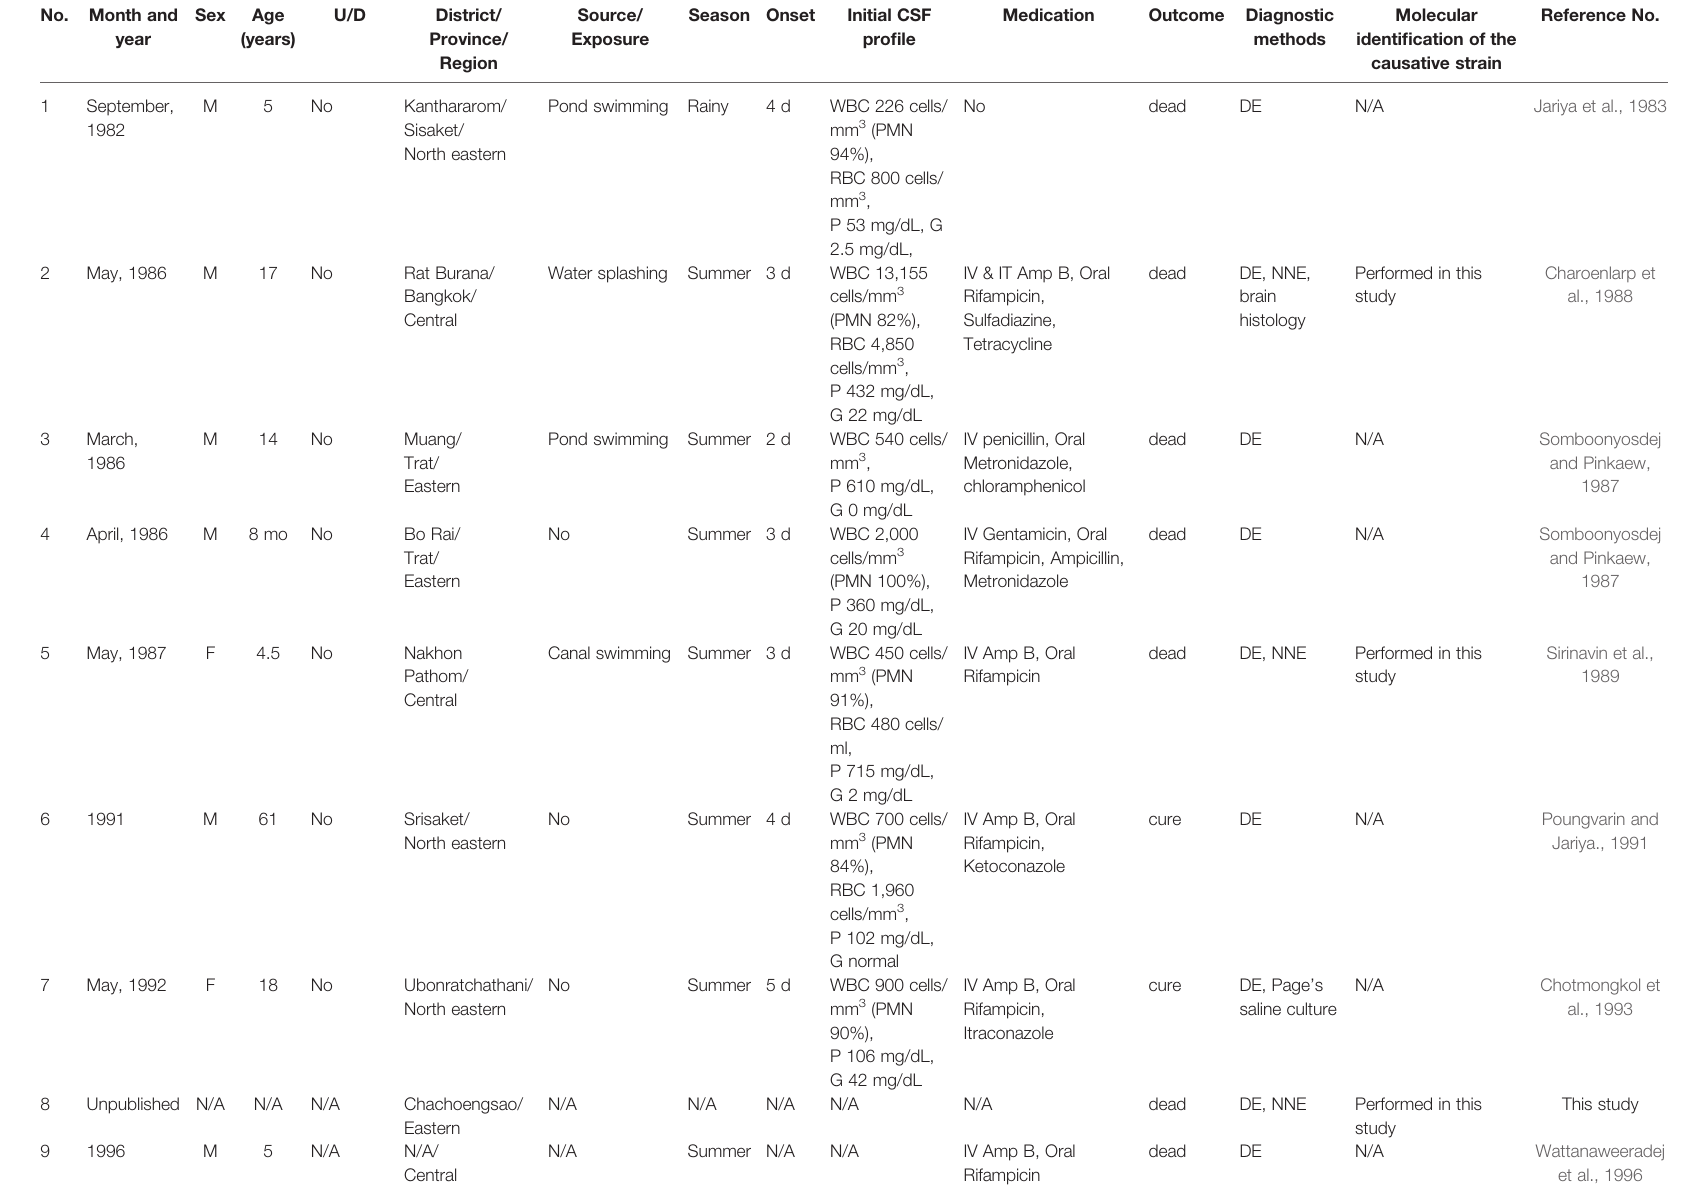
TABLE 1 | Demographic data, laboratory fi ndings and clinical characteristics of reported N. fowleri infection cases in Thailand. No. Month and